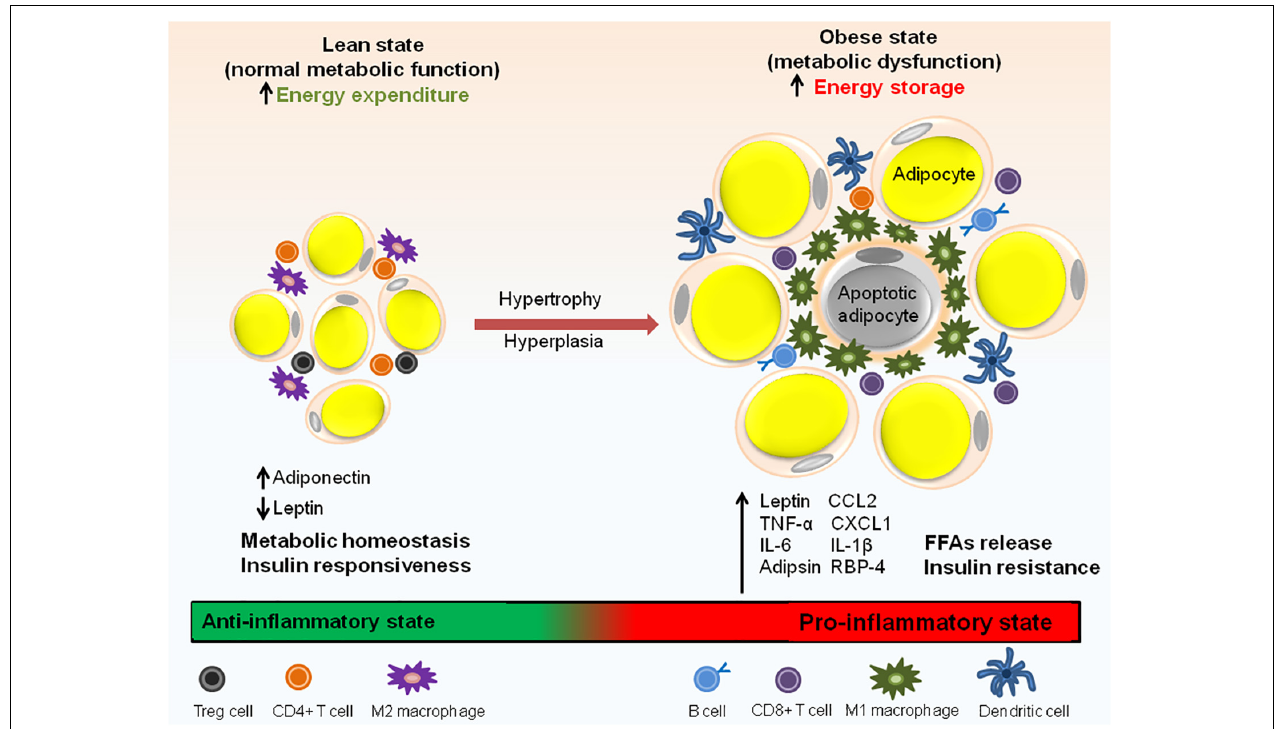
FIGURE 3 | Immune cell distribution in lean and obese state. In lean adipose tissue with normal metabolic function, M2 macrophages are uniformly distributed throughout the tissue. The lean AT milieu also consists of CD4+ T cells and Treg cells having anti-inflammatory properties. Adiponectin to leptin ratio is high which contributes to the insulin responsive state of the adipocytes. In obese state, macrophages switch to M1 type which forms a crown like structure (CLS) around the adipocytes. Adipocyte hypertrophy results in the rupture of adipocytes and releases FFAs. In addition to M1 macrophages, obese state is also associated with an increase in CD8 + T cells, dendritic cells and IgG antibody producing B cells responsible for pathogenic state of AT. Obesity is also associated with abnormal adipokine profile, i.e., increased release pro-inflammatory adipokines. Aberrant secretion of adipokines (leptin, IL-6, adipsin, RBP-4, and IL-1 β ), chemokines (CCL2 and CXCL1) and macrophage factors (TNF- α ) causes metabolic dysfunction and insulin